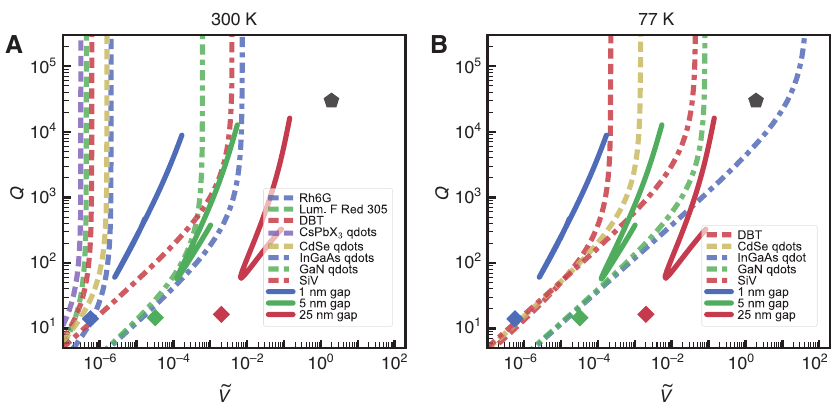
Figure 5: Strong coupling conditions for different emitters at room and liquid nitrogen temperatures. We find a threshold for the mode volume above which strong coupling becomes impossible. Upon cooling the emitters to liquid nitrogen temperatures, this threshold is relaxed by several orders of magnitude. We show the same cavity (black marker), antennas (colored diamonds) and hybrids (full colored lines) as in Figure 4C. At room temperature, Q , (cid:31) V are insufficient for strong coupling with most emitters. At 77 K, the reduced dephasing of the emitters relaxes the strong coupling condition such that the hybrids can reach strong coupling where the components